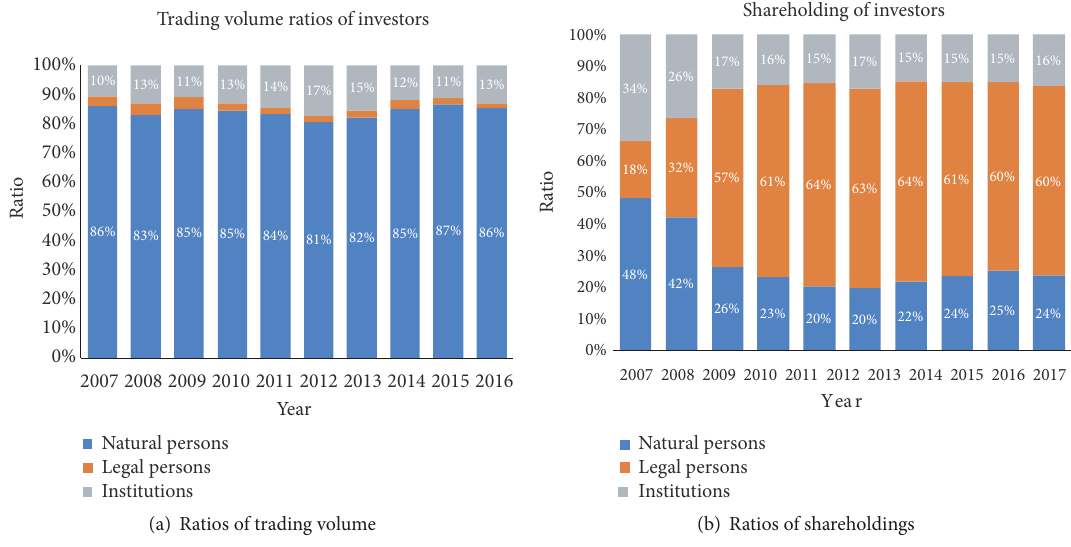
Figure 11: Structure ratios of investors in China’s stock market. Data source: Shanghai Stock Exchange Statistics